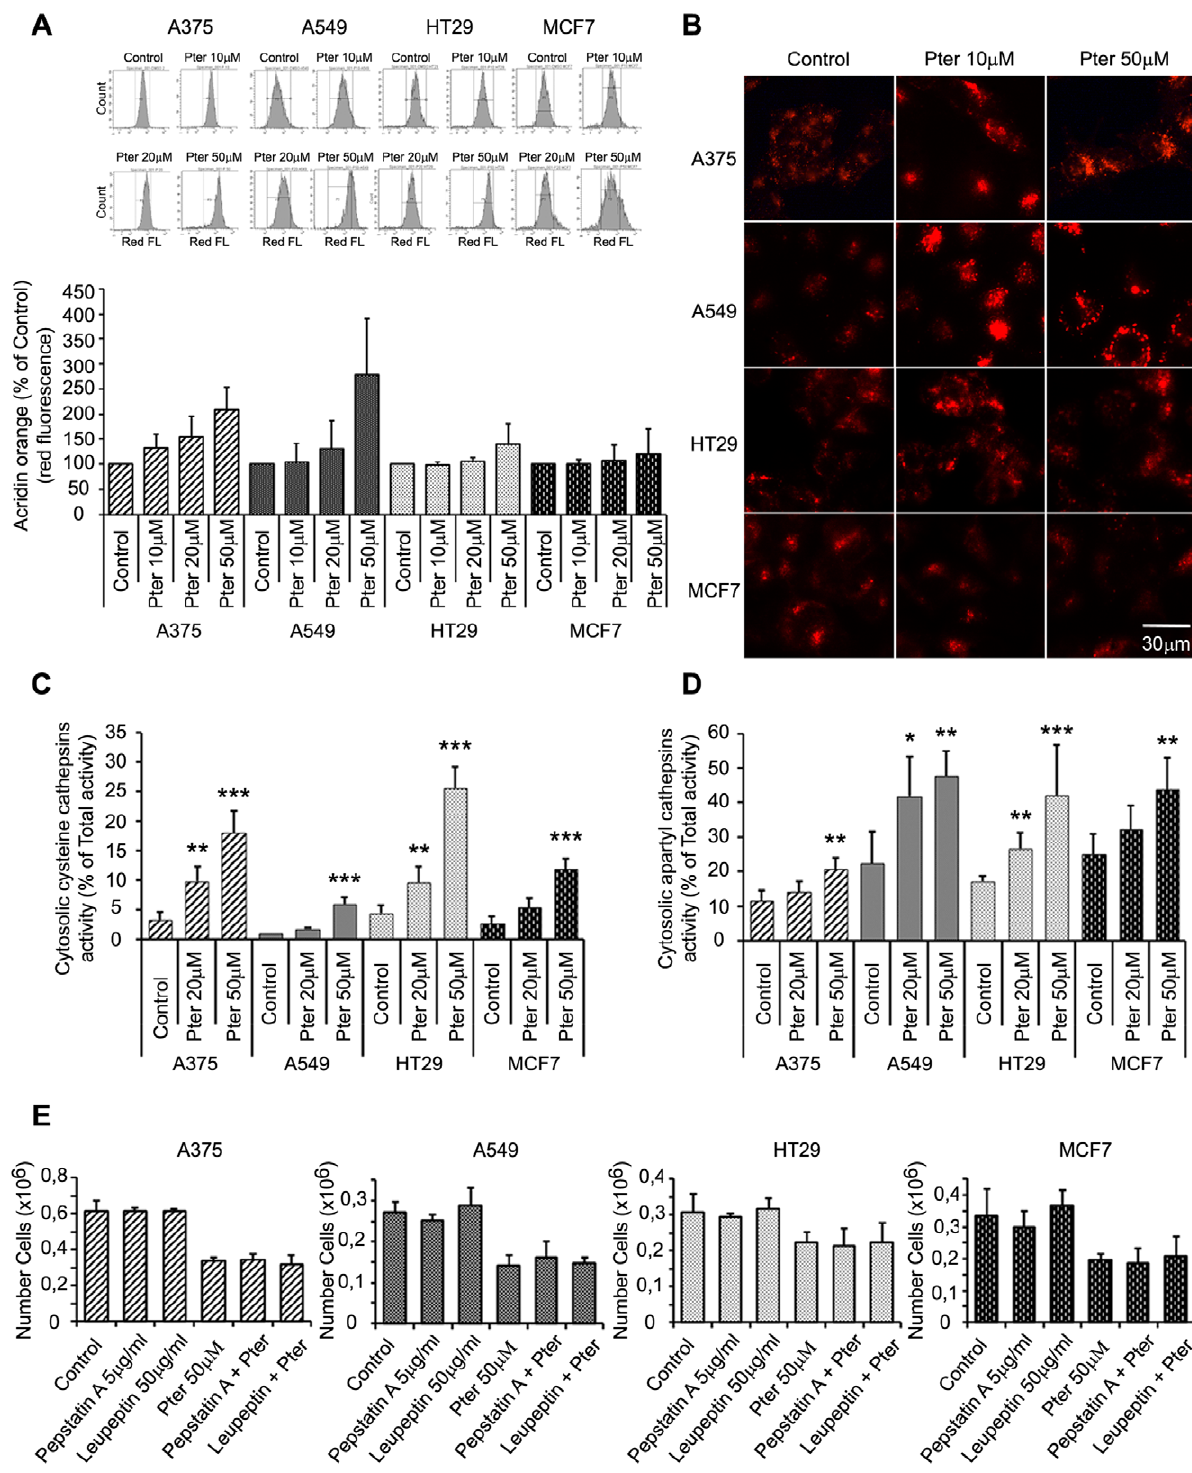
Figure 6. Pterostilbene induces lysosomal membrane permeabilization. A) Flow cytometry analysis of acridine orange staining after 24 h incubation with indicated concentrations of Pter. Increases in red fluorescence (x-axis), observed in treated cells, indicated changes at the lysosomal membrane. B) Microscopic images of Lysotracker red-stained cells untreated or treated with indicated concentrations of Pter for 24 h. C) Cytosolic cysteine cathepsin (zFRase) activity expressed as percentage of total activity (n=7) was measured 24 h after Pter addition. D) Cytosolic aspartyl cathepsin activity expressed as percentage of total activity (n=7) after 24 h of Pter treatment. The results were statistically analyzed by ANOVA and the Tukey test (*p , 0.05; **p , 0.01; ***p , 0.001 vs. control). E) Cathepsins B and D inhibitors, Leupeptin and Pepstatin A, were added 1 h prior to the addition of 50 m M Pter. Cell number was analyzed 24 h later.